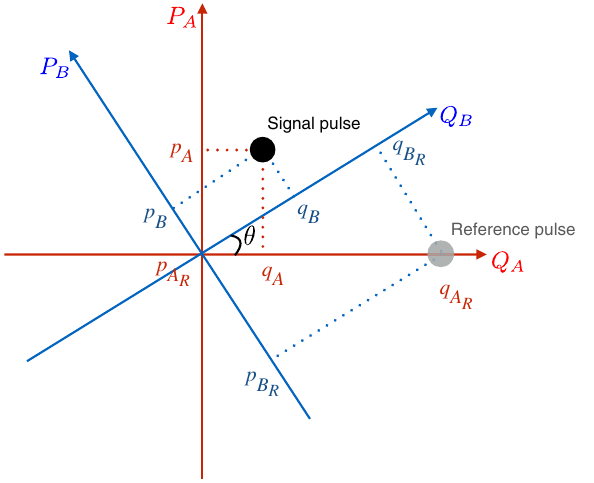
FIG. 2. The phase-space representation of Alice ’ s and Bob ’ s misaligned reference frames. The reference pulse is assumed to be on the Q A axis for Alice in this example, and the signal pulse is randomly